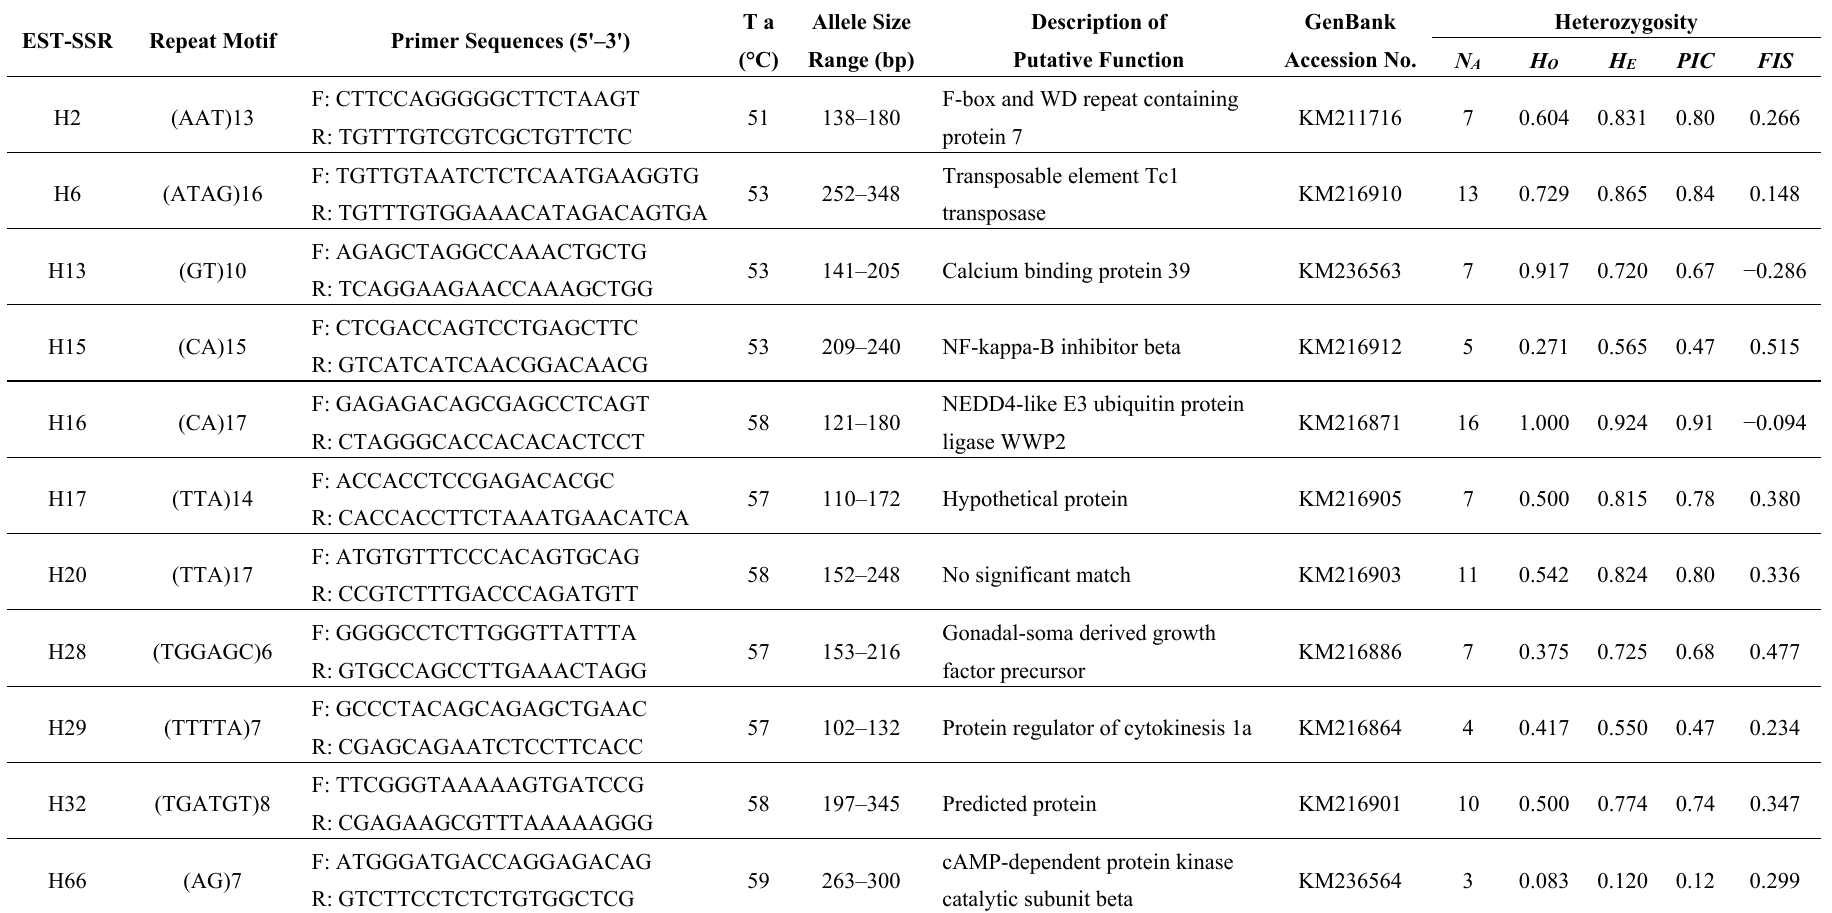
Table 2. Characteristics of the 57 EST-SSR markers for yellow catfish. Population genetic diversity analysis at 57 SSR loci was shown under the parameters: number of alleles per locus ( N A ), observed heterozygosity ( H O ), expected heterozygosity ( H E ), polymorphic information content ( PIC ) and fixation index ( FIS